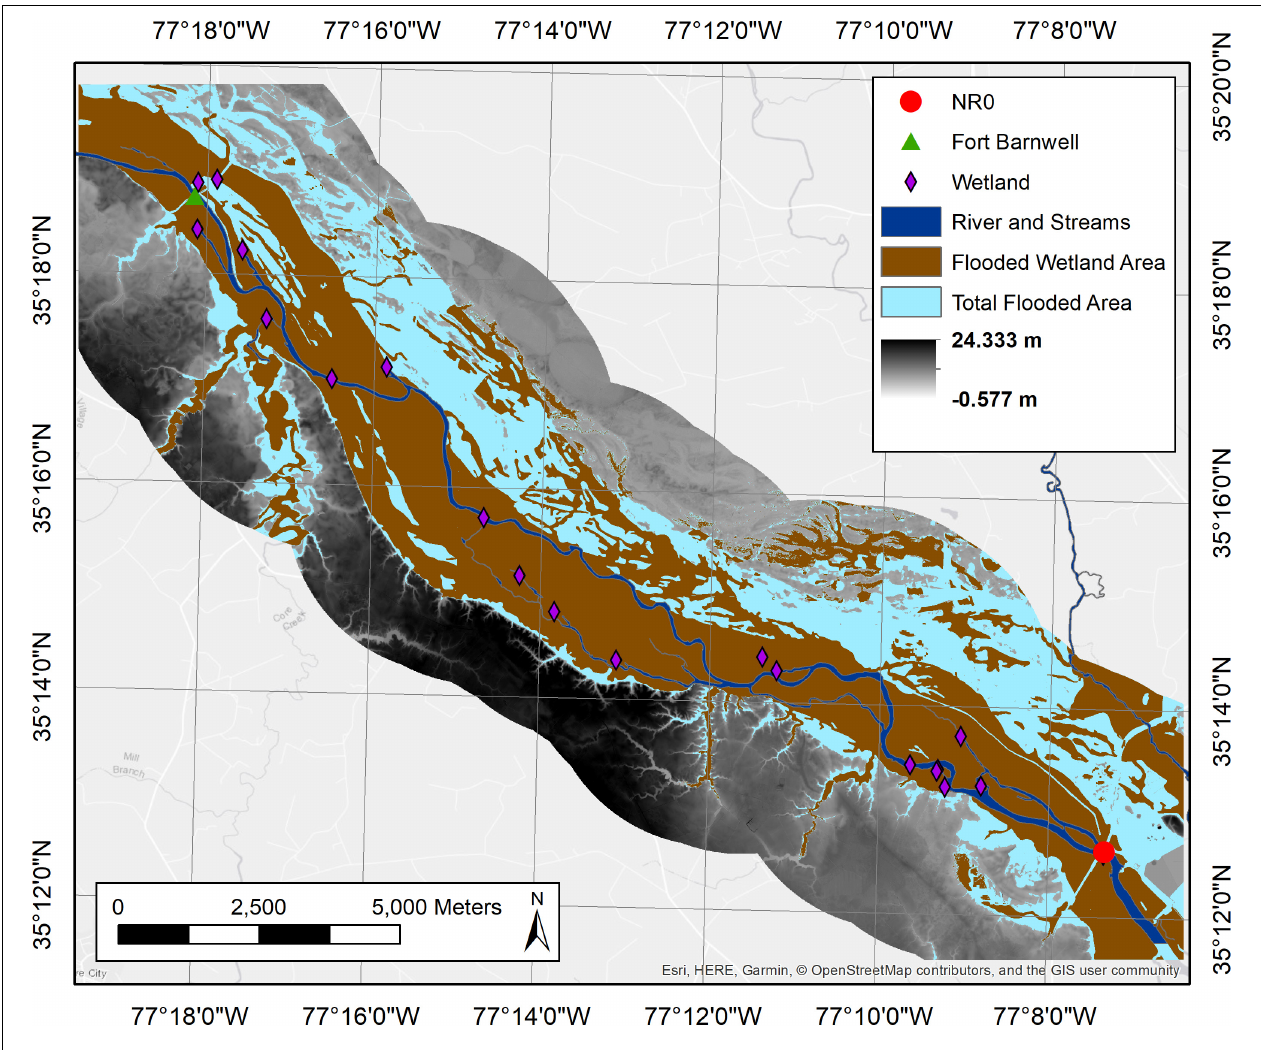
FIGURE 5 | Map showing maximum gauge height (5.844 m) from 16 October 2016 at USGS gaging station 02021814 near Fort Barnwell, NC of freshwater wetlands with DEM (Black and White), flooded area (light blue), and wetland flooded area (brown). TABLE 1 | Total flooded area, volume, and average depth for the total area and wetland area from geospatial flood model. Modeled gauge height